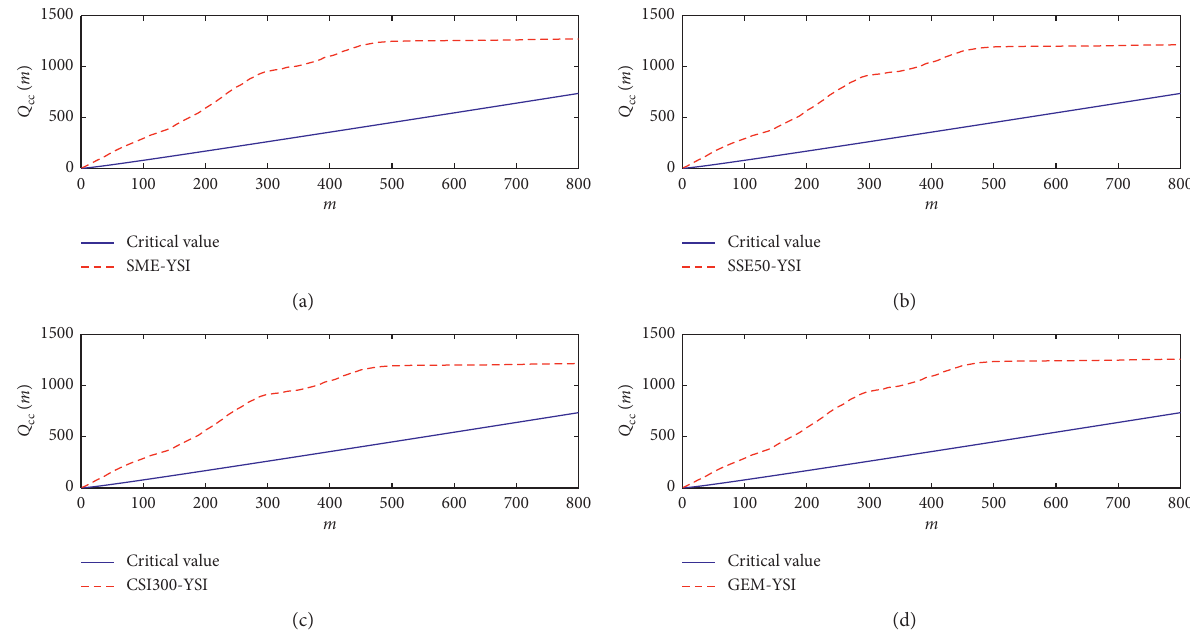
Figure 4: The cross-correlation statistic Q ( m ) for market participation willingness and Chinese stock market returns volatility. cc Table 3: The detrended cross-correlation coefficient ( ρ ( DCCA ) ) for a given window size s